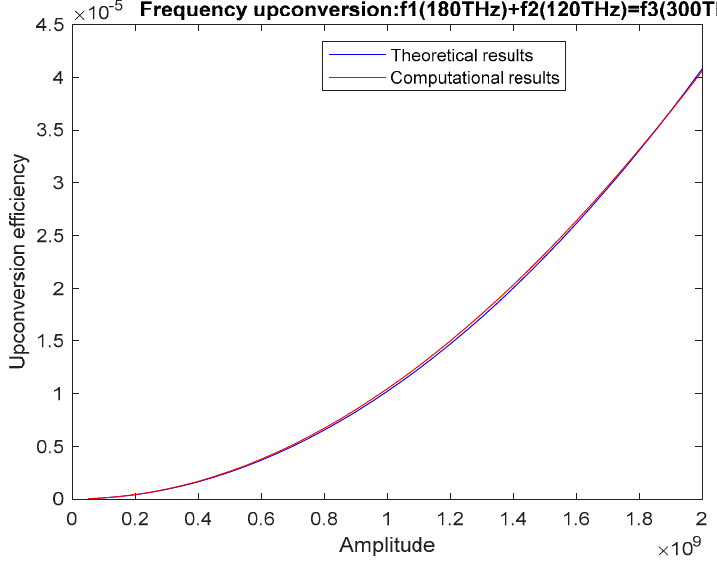
Figure 9. Comparison of the frequency up-conversion efficiencies for f 3 = 300 THz and d = 6.3 × 10 − 22 , versus the pump wave amplitude. Example 2: Optical amplification via non-linear wave mixing (parametric amplification).